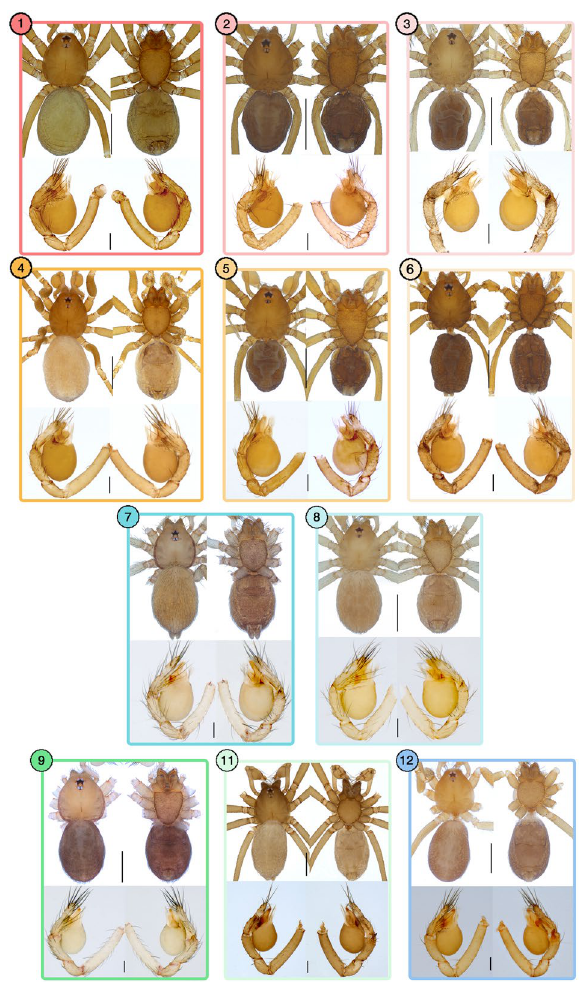
Figure 5. Morphological photographs of each cryptic species from Fig. 4. upper panels: habitus (dorsal and ventral view); lower panels: left palp (prolateral and retrolateral view), (6) for right palp (retrolateral and prolateral view). The numbers of each panel match the numbers from Fig. 4. Scale bars: upper panels = 0.5 mm, lower panels = 0.1